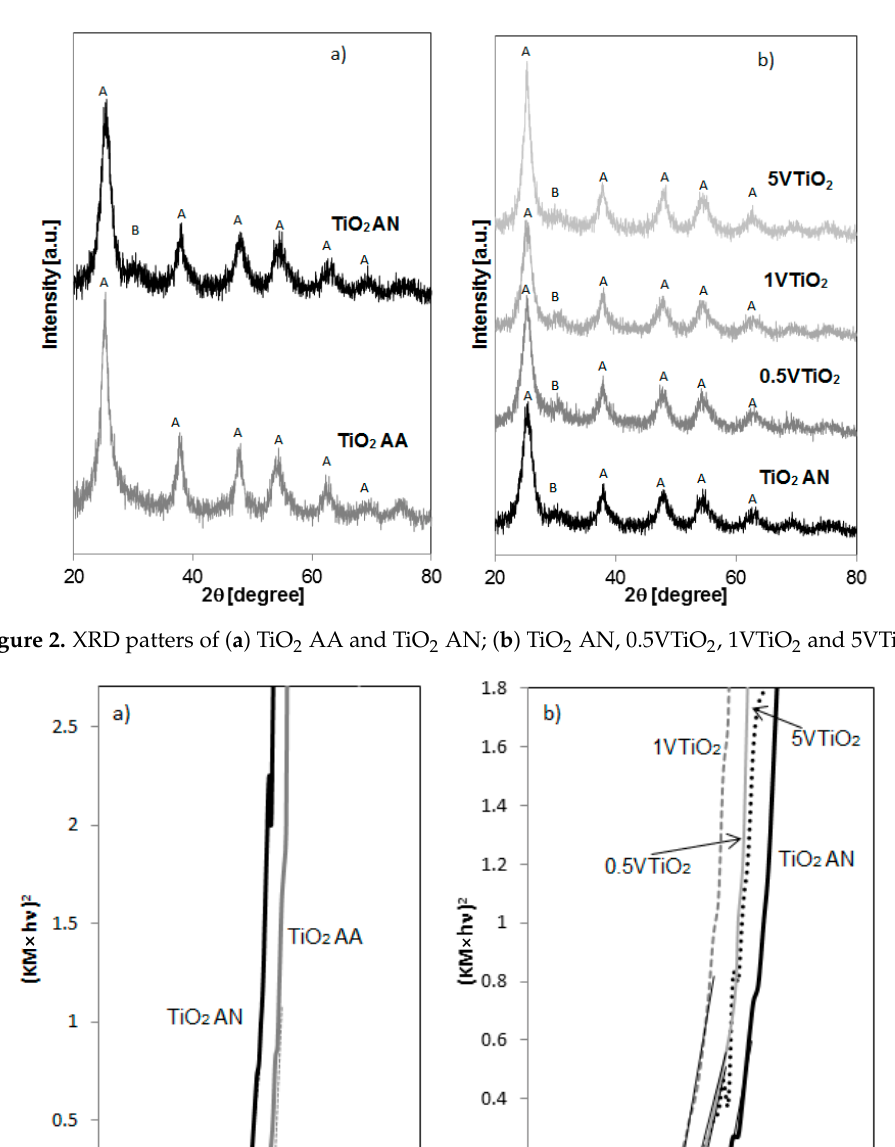
Figure 4. Photocatalytic degradation of caffeine using TiO 2 AA and TiO 2 AN under UV irradiation. In particular, the best results were obtained using TiO 2 AN sample leading to a degradation of 80% after 360 min of UV irradiation. A lower activity was achieved for TiO 2 AA photocatalyst (caffeine degradation of 51% after 360 min of UV irradiation). This result could be due to the presence of biphase (anatase, brookite) that allowed a slight decrease in the TiO 2 AN particle size and decrease